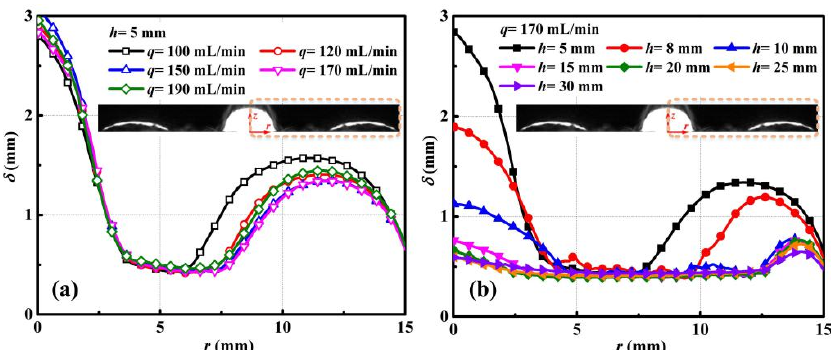
Figure 6. Time-average film thickness along the radial direction of the surface, ( a ) variations of the time-average film thickness under different mass flow rates, ( b ) variations of the time-average film thickness under different impingement distances.